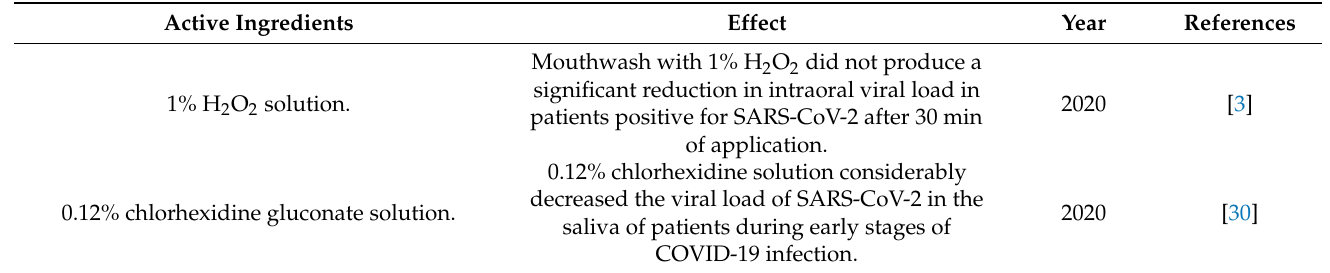
Table 2. Clinical trials and in vivo assays of the antiviral efficacy of active ingredients against